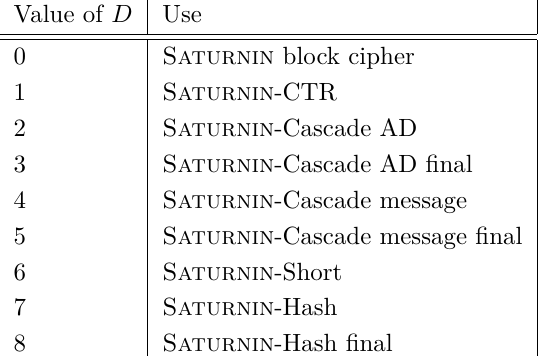
Table 2: Correspondence between the value of the domain separator 𝐷 and the usage of Saturnin D